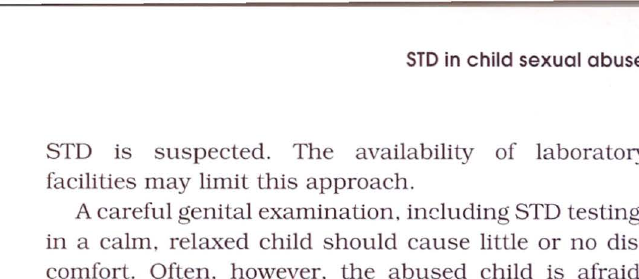
TABLE 2 Sites for specimen collection to diagnose sexually trans mitted diseases in prepubertal children Pharynx Neisseria gonorrhoeae culture Rectum Neisseria gonorrhoeae